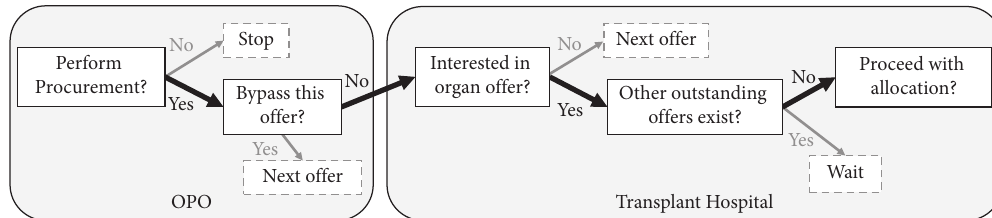
Figure 1: Simplified decision tree of OPOs and transplant hospitals during organ allocation. Allocation begins with the decision to perform procurement of a deceased donor. The term “procurement” in this illustration is abstract and represents the decision to work with hospitals on attempting to allocate the donor’s organs to candidates. OPOs may decide to bypass certain offers, but must document the reason for the exception. Once a transplant hospital is notified, they can either express interest in the offer or decline it outright. Only when no other preceding offers exist does a transplant hospital become the primary responder. Ultimately, the decision to perform procurement and transport donor organs to the accepting facility lies with the OPO.